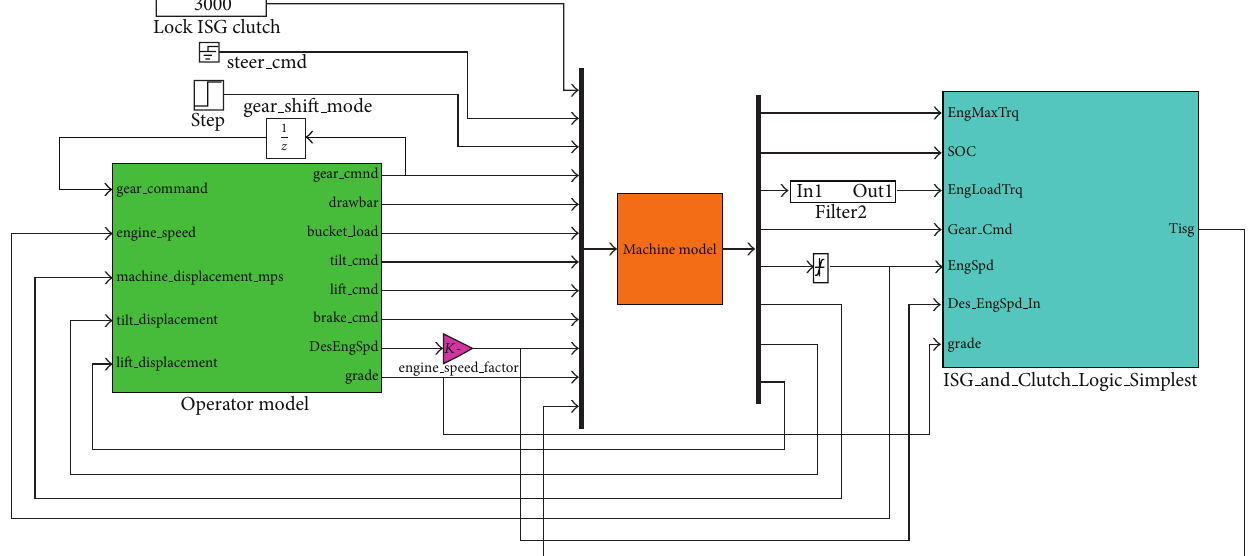
Figure 10: Rule–based control upper level Simulink diagram.